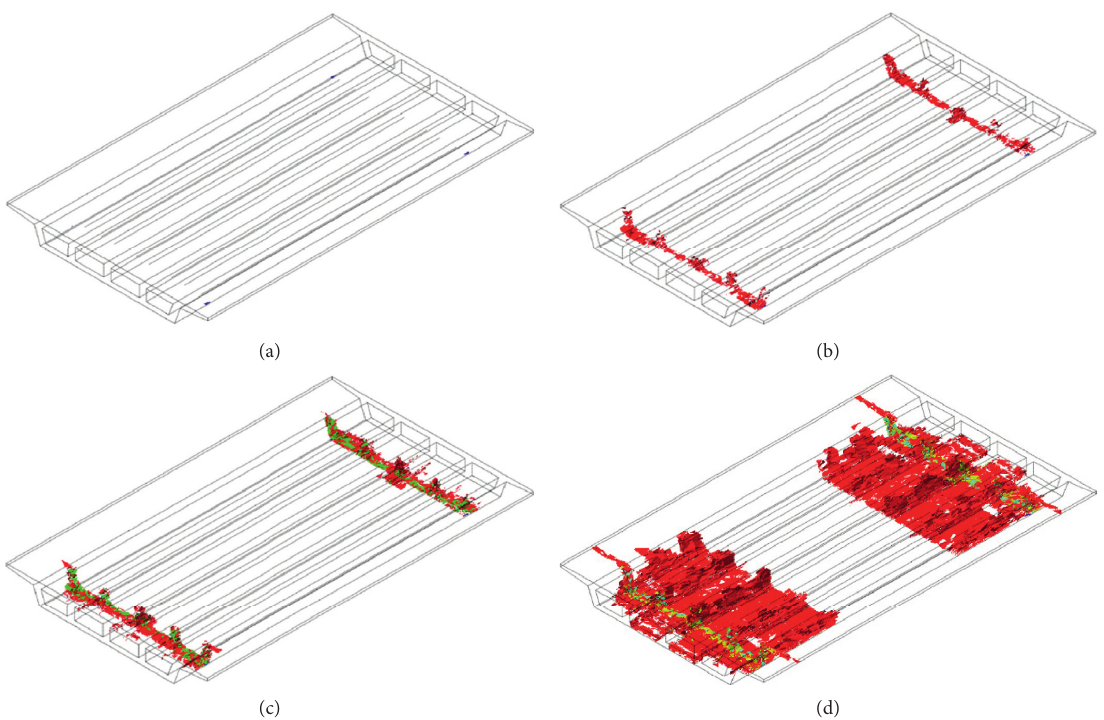
Figure 10: Crack development of box-girder. (a) P 1 � 10200kN. (b) P 2 � 10455kN. (c) P 3 � 10701kN. (d) P 4 � 10956kN.